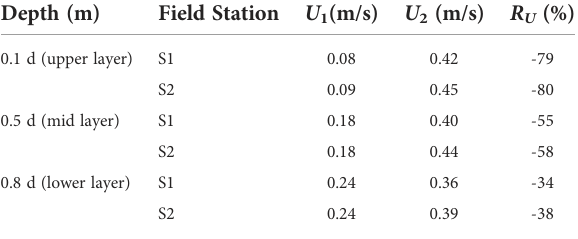
TABLE 4 The average relative difference of velocity R U (%) between with ( U 1 ) and without farm ( U 2 ). Depth